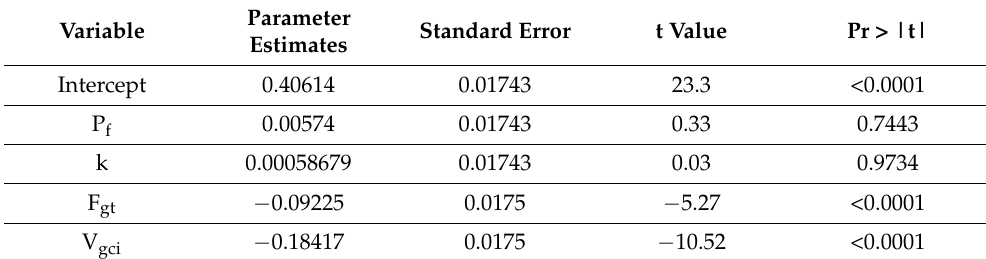
Table 2. Sensitivity analysis result for the bleed down.